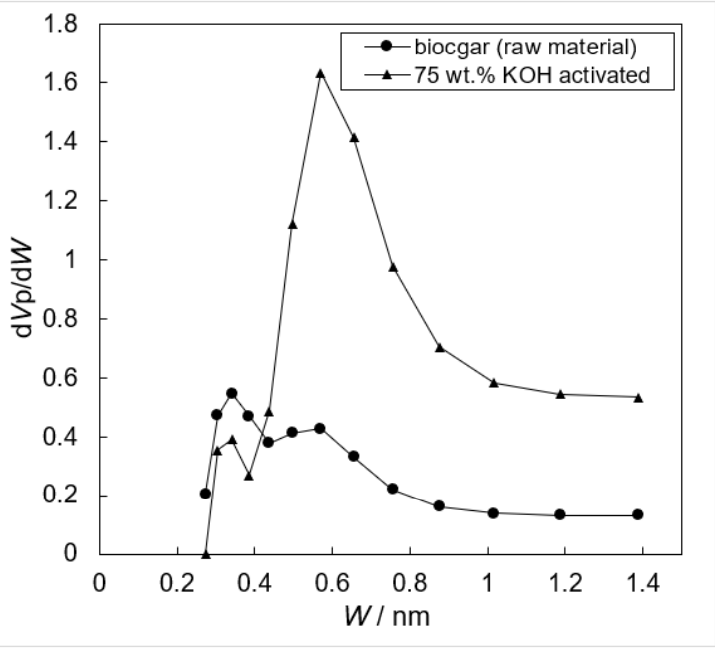
Figure 5. The micropore size distribution determined from CO 2 adsorption isotherms by using the GCMC